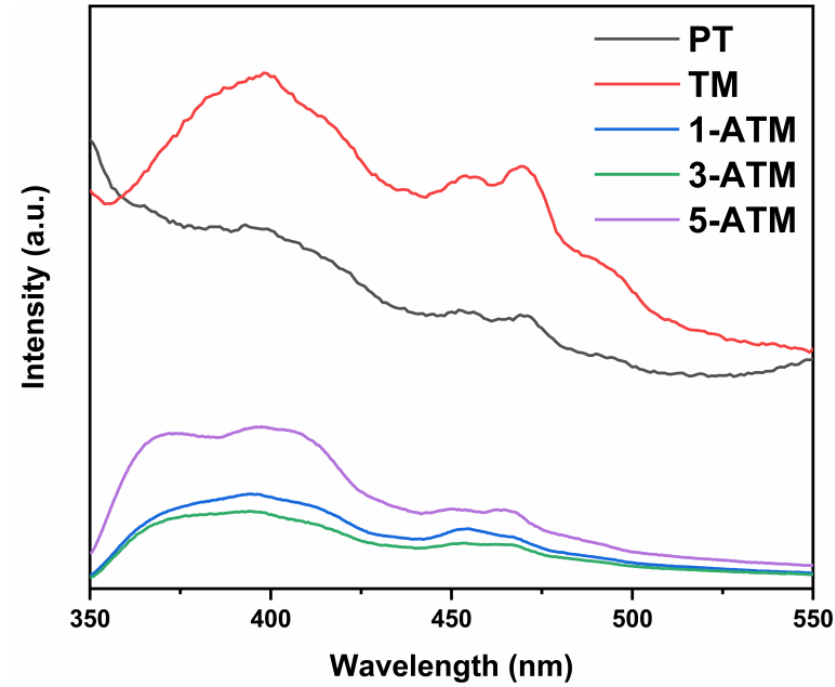
Figure 7. Photoluminescence spectra of PT, TM and ATM.